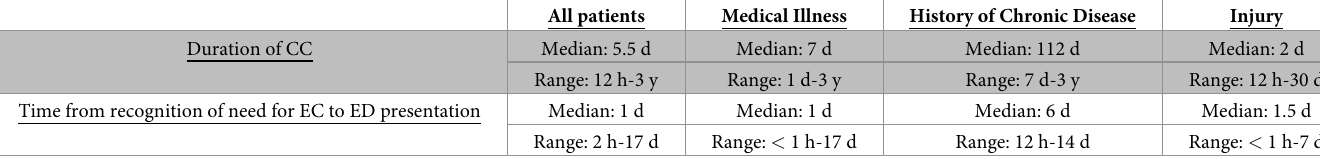
All patients Medical Illness History of Chronic